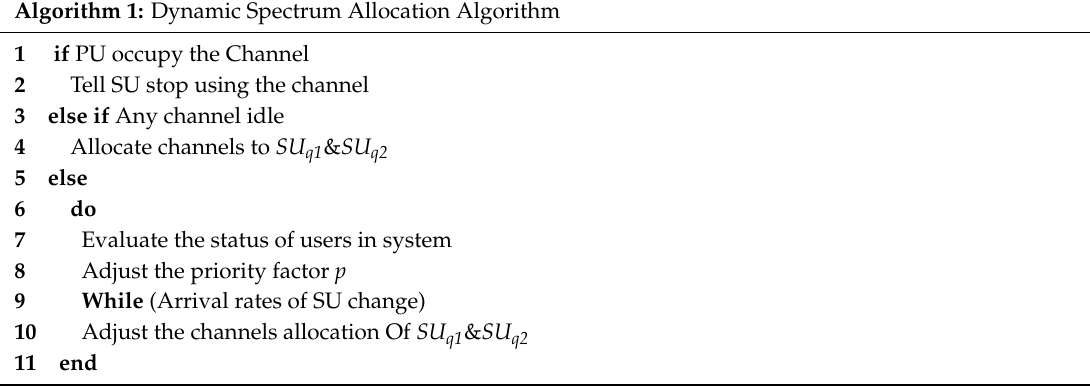
Algorithm 1: Dynamic Spectrum Allocation